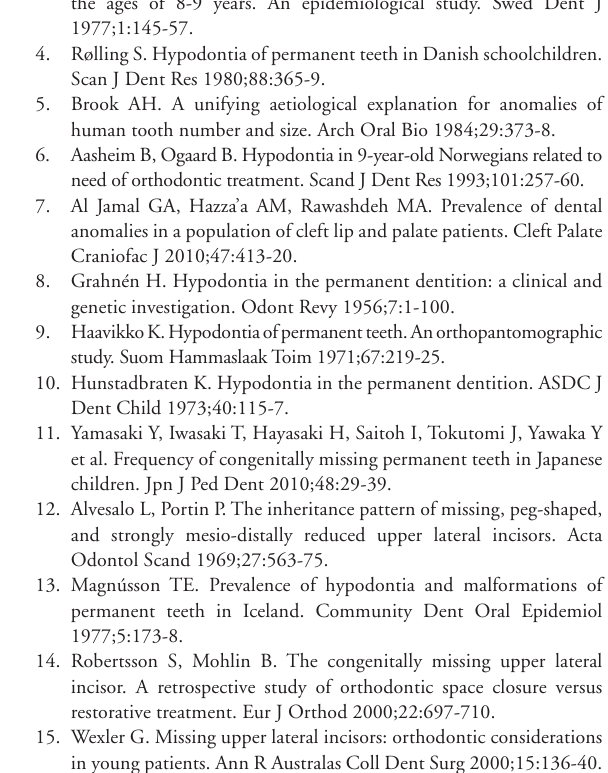
Figure 3. Clinical application of wet denture tooth technique to restore space from missing upper left lateral incisor (arrow).